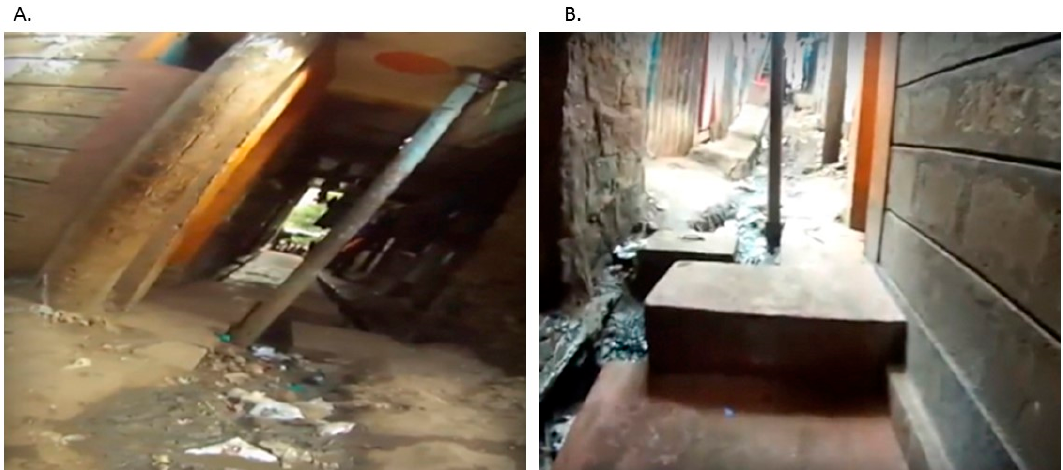
Figure 2. The point of intersection between two paths. ( A ) is from a video taken on 19 March 2014 and ( B ) on 8 October 2015. ( A ) was taken from the opposite direction with respect to ( B ). Features used to validate both path’s correct coordinate location include the orange painted wall, the pole, the striped pattern on the wall, and the drain.